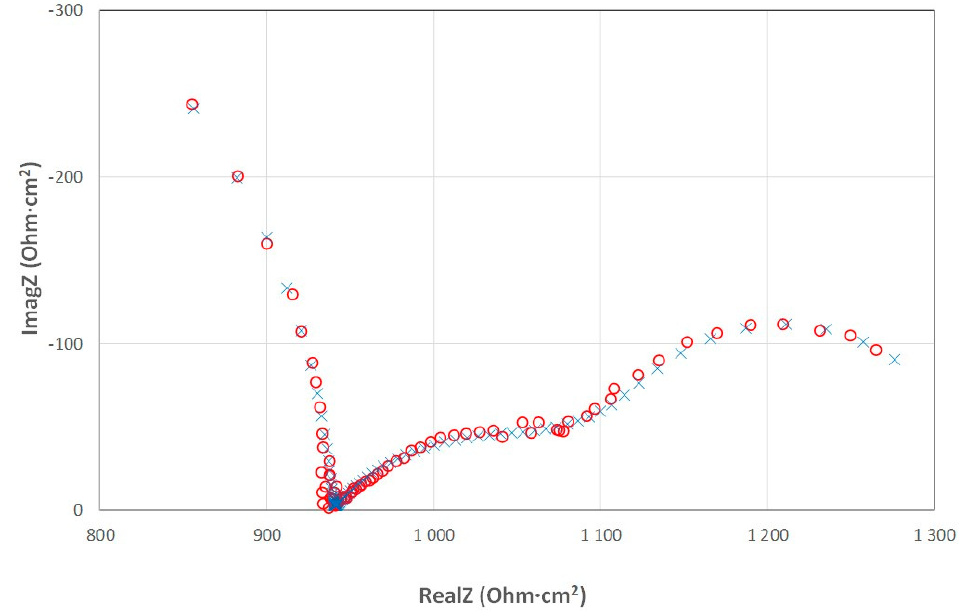
Figure 5. EIS results after eight days of testing at 300 °C and 35 cc/kg dissolved hydrogen. Red circles = measured data, Blue crosses = fit result.